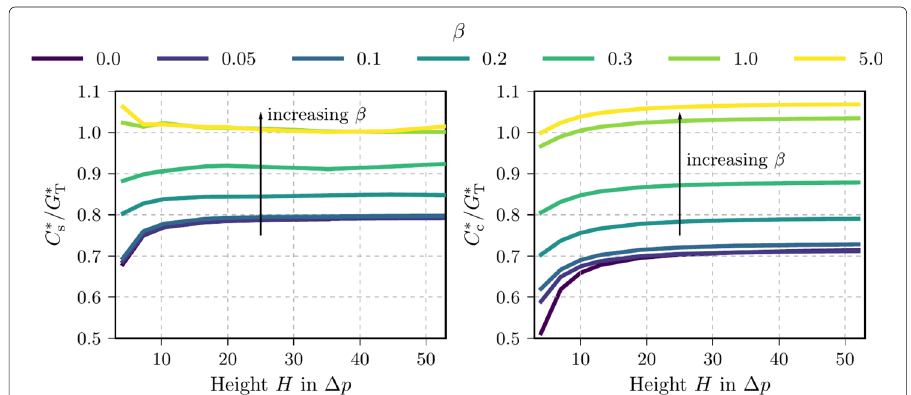
Fig. 7 Normalized system responses for different irregularities under double-clamped simple shear loading; left: beam models, right: Cosserat continuum models; disorder-dependent Cosserat parameters as in Fig.